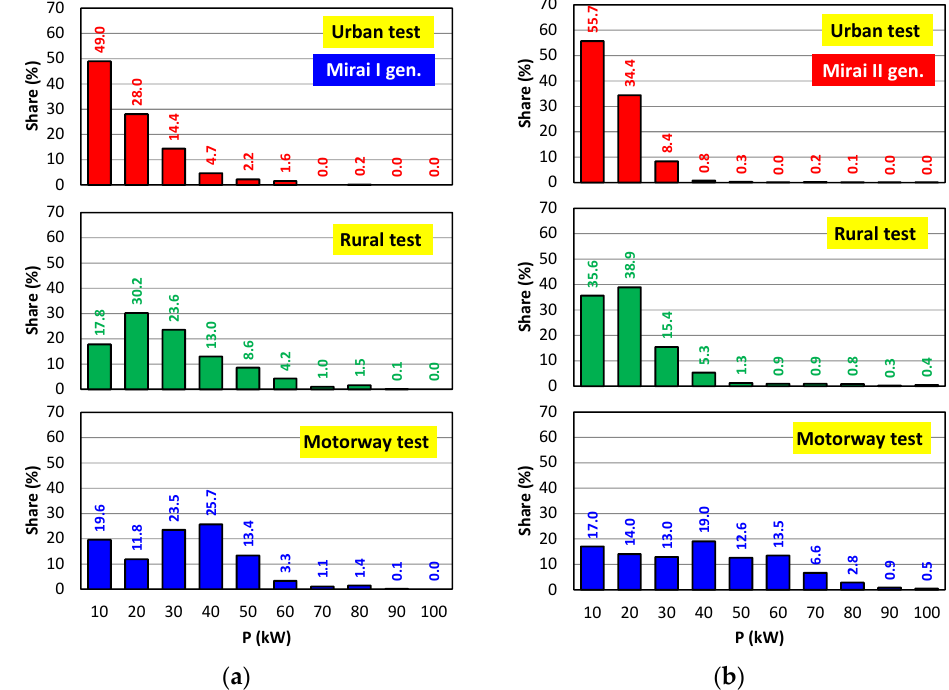
Figure 14. The proportion of the fuel cell power share relative to the battery power: ( a ) for the 1st generation vehicle; ( b ) for the 2nd generation vehicle.